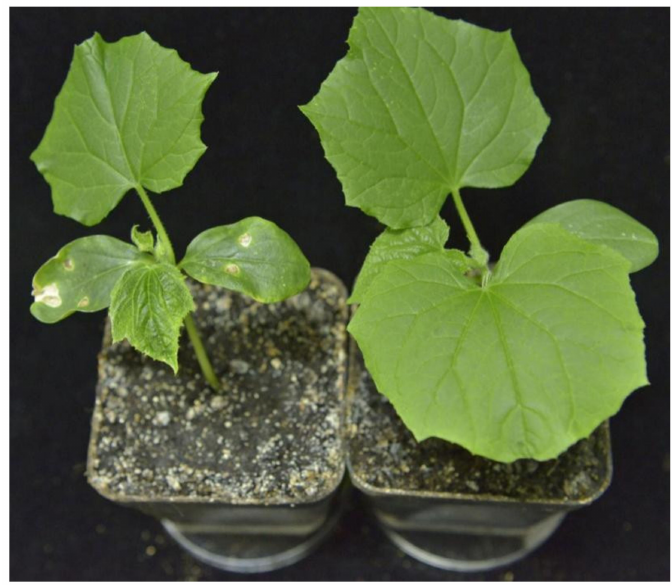
Figure 1. The symptoms of prunus necrotic ringspot virus (PNRSV)-infected Cucumis sativus ( left ) and healthy plant ( right